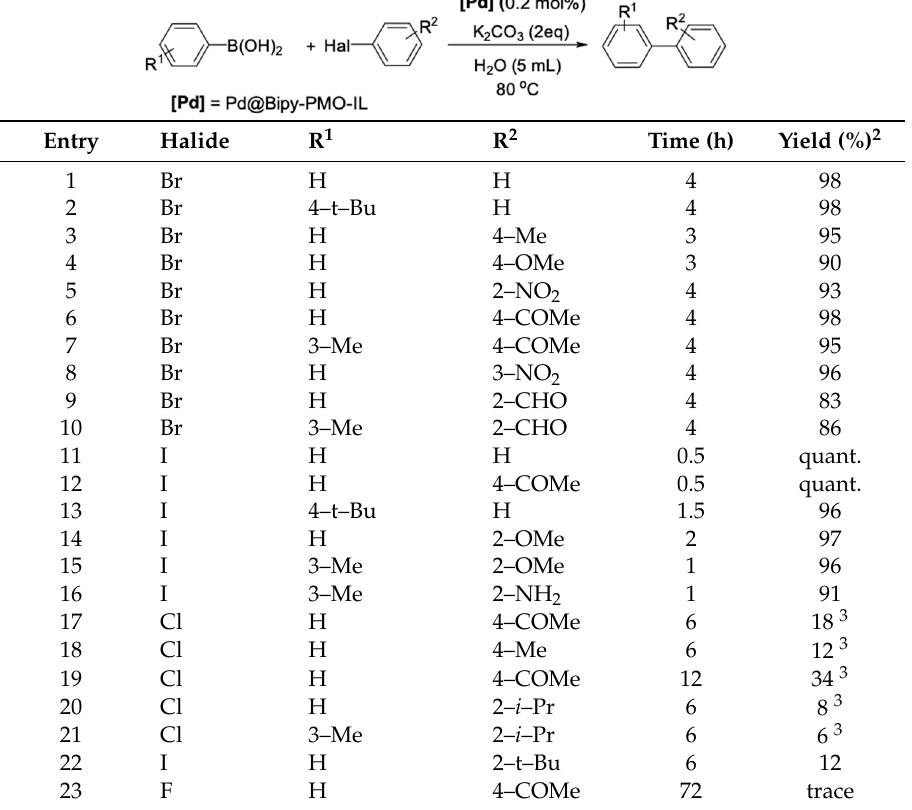
Table 1. Suzuki cross-coupling reactions of various aryl halides and bronic acid substrates catalyzed by Pd@Bipy–PMO 1 .